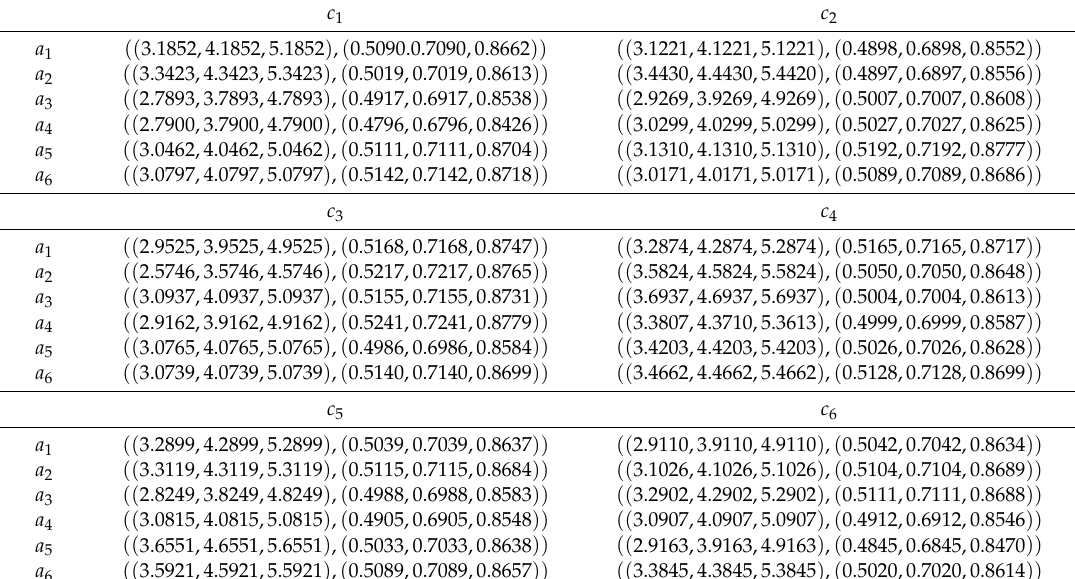
Table A4. The transformed evaluation information of